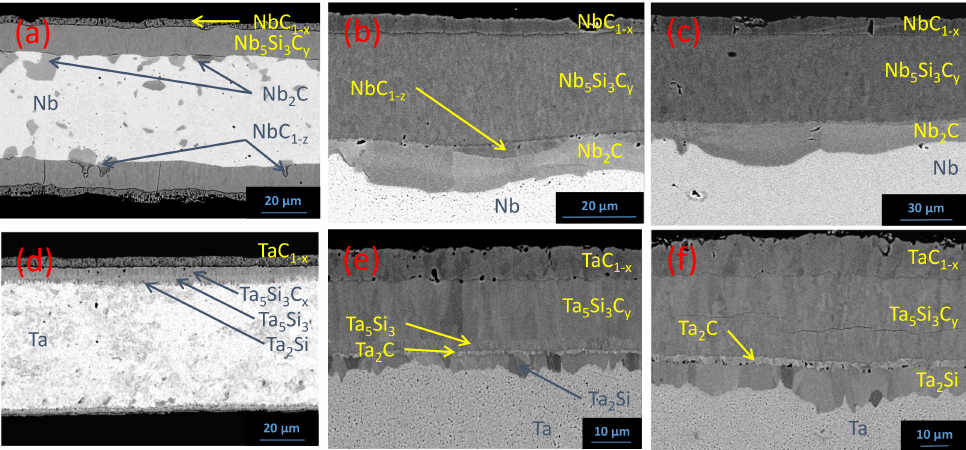
Figure 12. Reaction layers in the Nb/SiC ( a – c ) and in the Ta/SiC ( d – f ) systems after 1000 h at 1050 ◦ C, 100 h at 1350 ◦ C and 48 h at 1500 ◦ C,